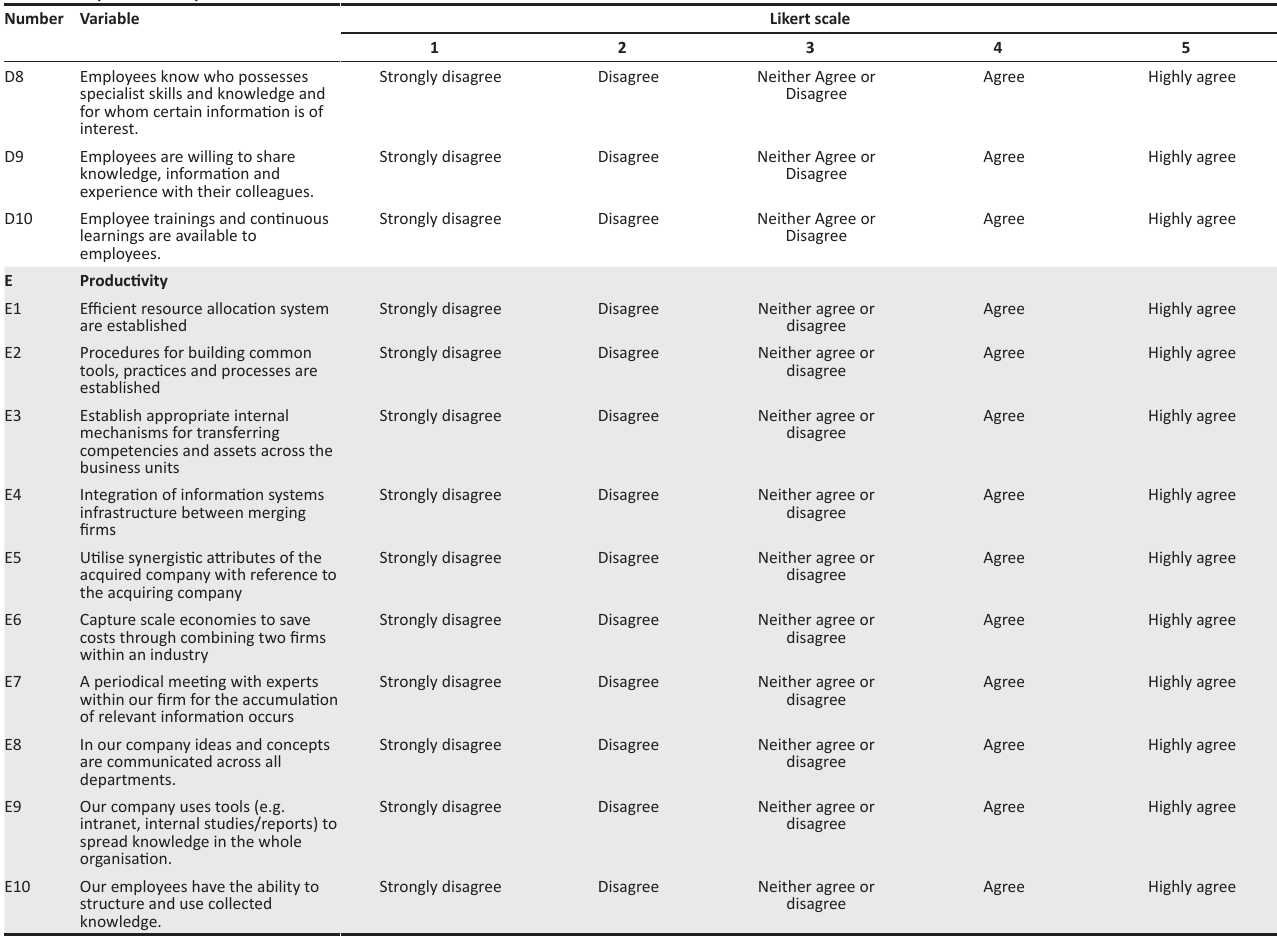
TABLE 1-A1 (Continues...): Questionnaire. Number